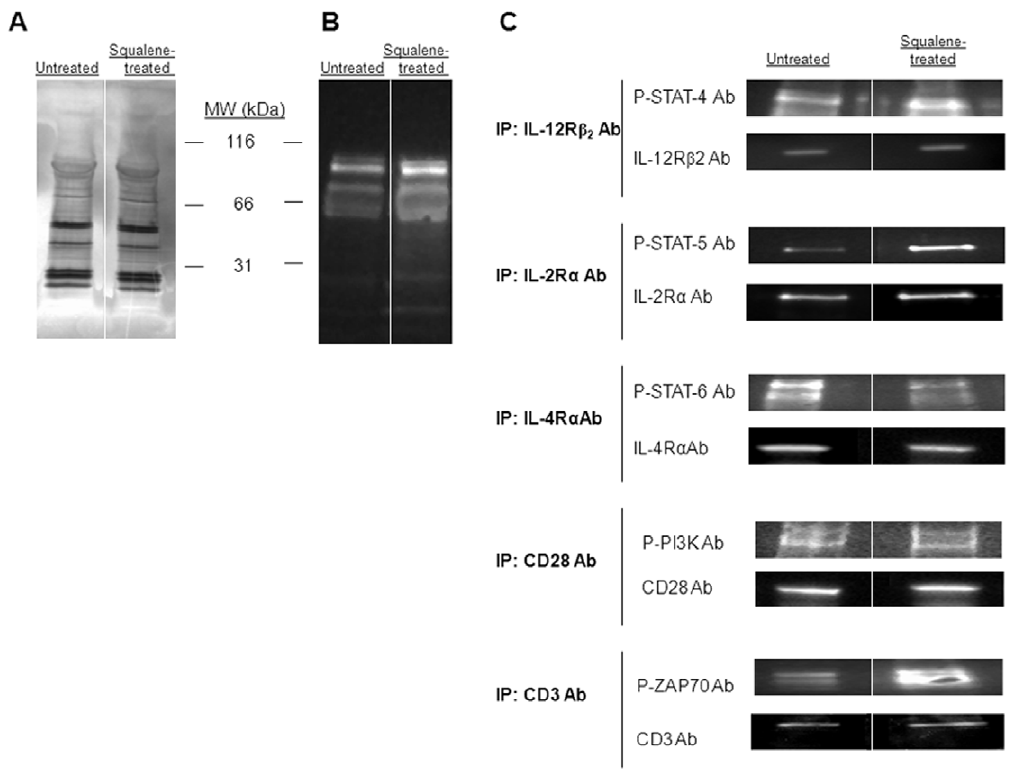
Figure 3. Tyrosine phosphorylation patterns of major signaling modules of T helper differentiation upon enrichment of membrane cholesterol. ( A ) SDS-PAGE silver stain of pooled, negatively-sorted CD4 + splenic T-cell lysates from F1 mice (n=4/group) untreated ( left lane ) or squalene treated (single dose of 180 m g, right lane ) 3 days post-injection shows no detectable quantitative alterations in the protein bands between the two groups of mice. ( B ) Tyrosine phosphorylation patterns of the same samples in panel A were blotted with anti-phosphorylated tyrosine Ab- HRP conjugate. Of note, the amount of 55–100 kDa phosphorylated protein bands is increased in mice treated with squalene. ( C ) Immunoprecipitation of pooled splenic CD4 + T-cell lysates from F1 mice treated or not with squalene (180 m g/mouse, n=4/group) 3 days post- injection was carried out for IL-12R b 2, IL-2R a , IL-4R a , CD28, or CD3 receptors using specific Abs, and probed with specific anti-phospho Abs for STAT4, STAT5, STAT6, PI3K, and ZAP-70 kinases. Only the phosphorylated STAT-4, STAT-5, and ZAP-70 in squalene treated mice were significantly enhanced. Shown is one of two representative experiments.